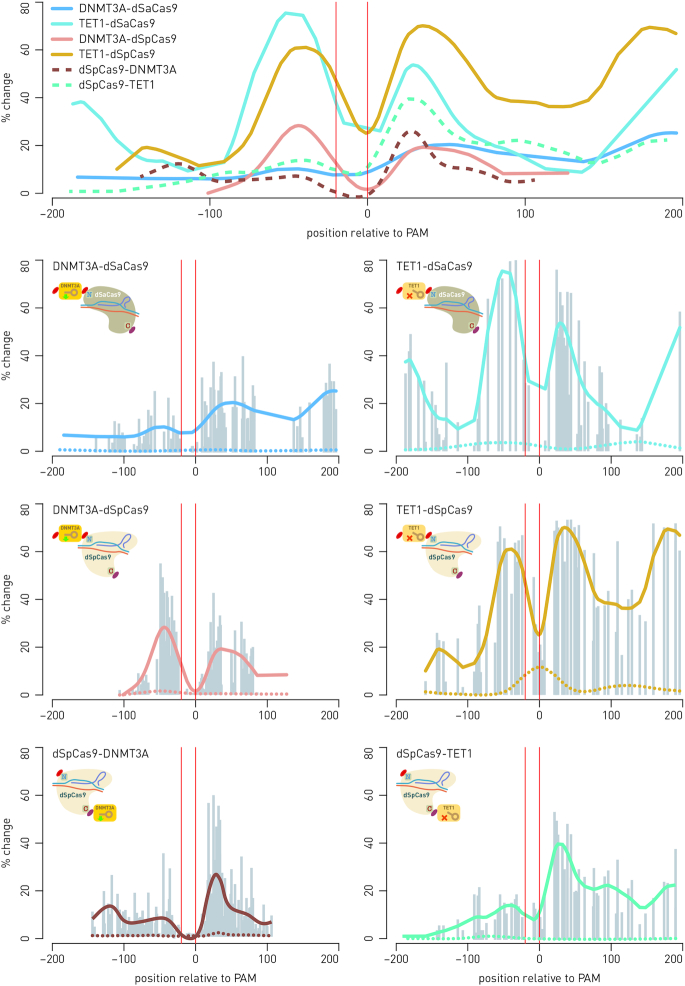
N- and C-terminal fusions of DNMT3A and TET1 catalytic domains to dCas9 orthologs from Streptococcus pyogenes and Staphylococcus aureus show similar activity profiles. Top panel shows summary of similar activity profiles for all combinations of effector domains (catalytic domains of DNMT3A or TET1) to C- or N-terminus of either dSpCas9 or dSaCas9 orthologs. The dSpCas9 C-terminal fusions show activity concentrated mainly downstream from the targeted sequence, while all N-terminal fusions had activity distributed equally up- and downstream from the gRNA binding site. The peak of change in CpG methylation appears at around 30 bp on either side of the dCas9-binding site (indicated by vertical red lines). The percentage of change is defined as absolute increase (for fusions with DNMT3A) or decrease (for fusions with TET1) in CpG methylation level (averaged from multiple independent experiments). Individual figures represent profiles of individual dCas9-fusions and summarize multiple experiments as a result of targeting certain loci using specific gRNA molecules: fusions DNMT3A-dSpCas9 and DNMT3A-dSaCas9 were targeted to BACH2 using six gRNAs specific for dSpCas9, or five gRNAs specific for dSaCas9, and one dual gRNA for both orthologs; fusions TET1-dSpCas9 and TET1-dSaCas9 were targeted to MGAT3 using four gRNAs specific for dSpCas9 and four gRNAs specific for dSaCas9, and one dual gRNA for both orthologs; fusion dSpCas9-TET1 was targeted to MGAT3 using eight gRNAs, and fusion dSpCas9-DNMT3A was targeted to BACH2 and IL6ST using eight gRNAs and four gRNAs, respectively (27). Gray bars show data points from individual experiments and represent methylation change at a certain distance from the gRNA binding site. Dotted lines in individual figures of the activity profiles show that catalytically inactive fusions elicit no changes of methylation level.